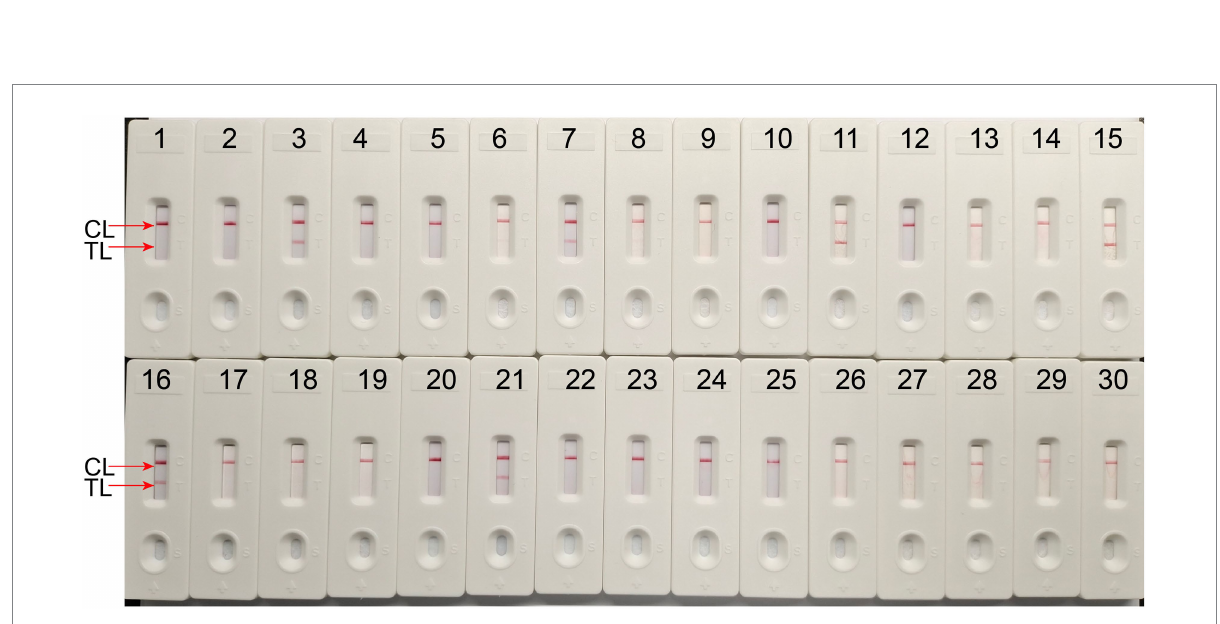
FIGURE 6 The LAMP-LFB assay for detecting H. influenzae in clinical samples. Later flow biosensor was applied for detecting LAMP amplicons. The numbers 3, 7, 11, 15, 16, 21 represented the positive results. 1–2, 4–6, 8–10, 12–14, 17–20, 22–30 represented the negative results.